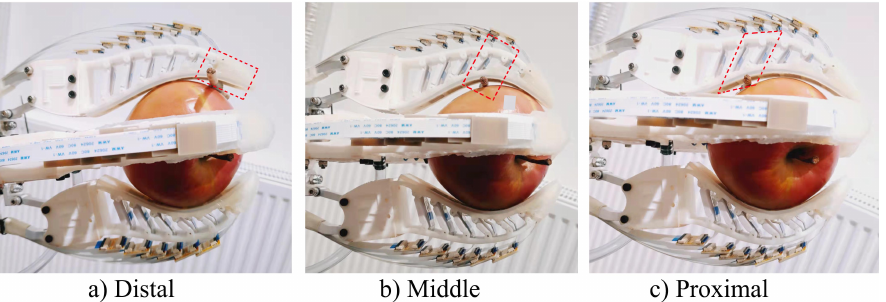
Figure 10. Three different branch interference